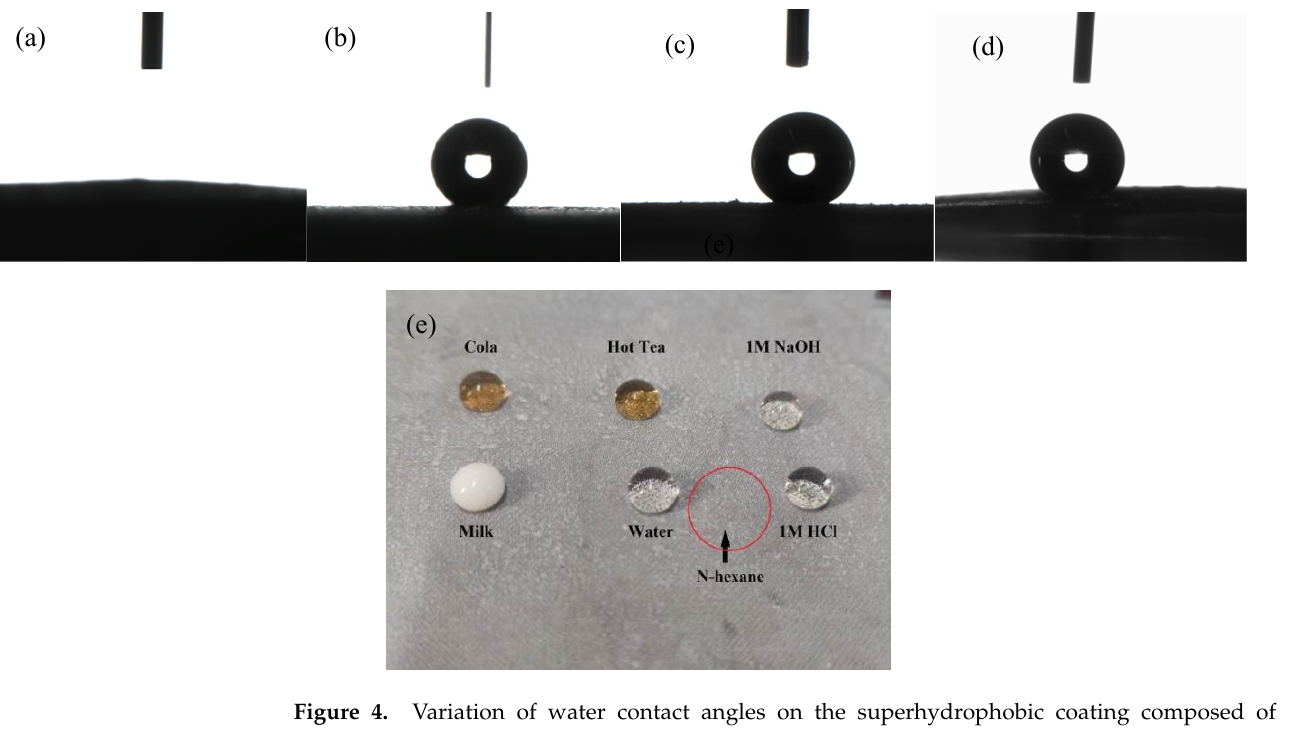
( d ) Figure 3. SEM images of ( a , b ) uncoated and ( c , d ) coated mesh. 3.3. Contact Angle Measurement The surface wettability of the coated SSM was characterized by water contact angle, as shown in Figure 4. The contact angle of the pretreated SSM was almost 0 (Figure 4a), and the water droplets rapidly penetrated. The composite coating gave the SSM superhy- drophobic propertidx, and the contact angle reached 155° ± 0.5° (Figure 4b). Figure 4c,d show the influence of the pH on contact angle. The contact angle decreases slightly in the range of pH value from 1 to 14, but is greater than 150°. The water droplets with pH of 1,